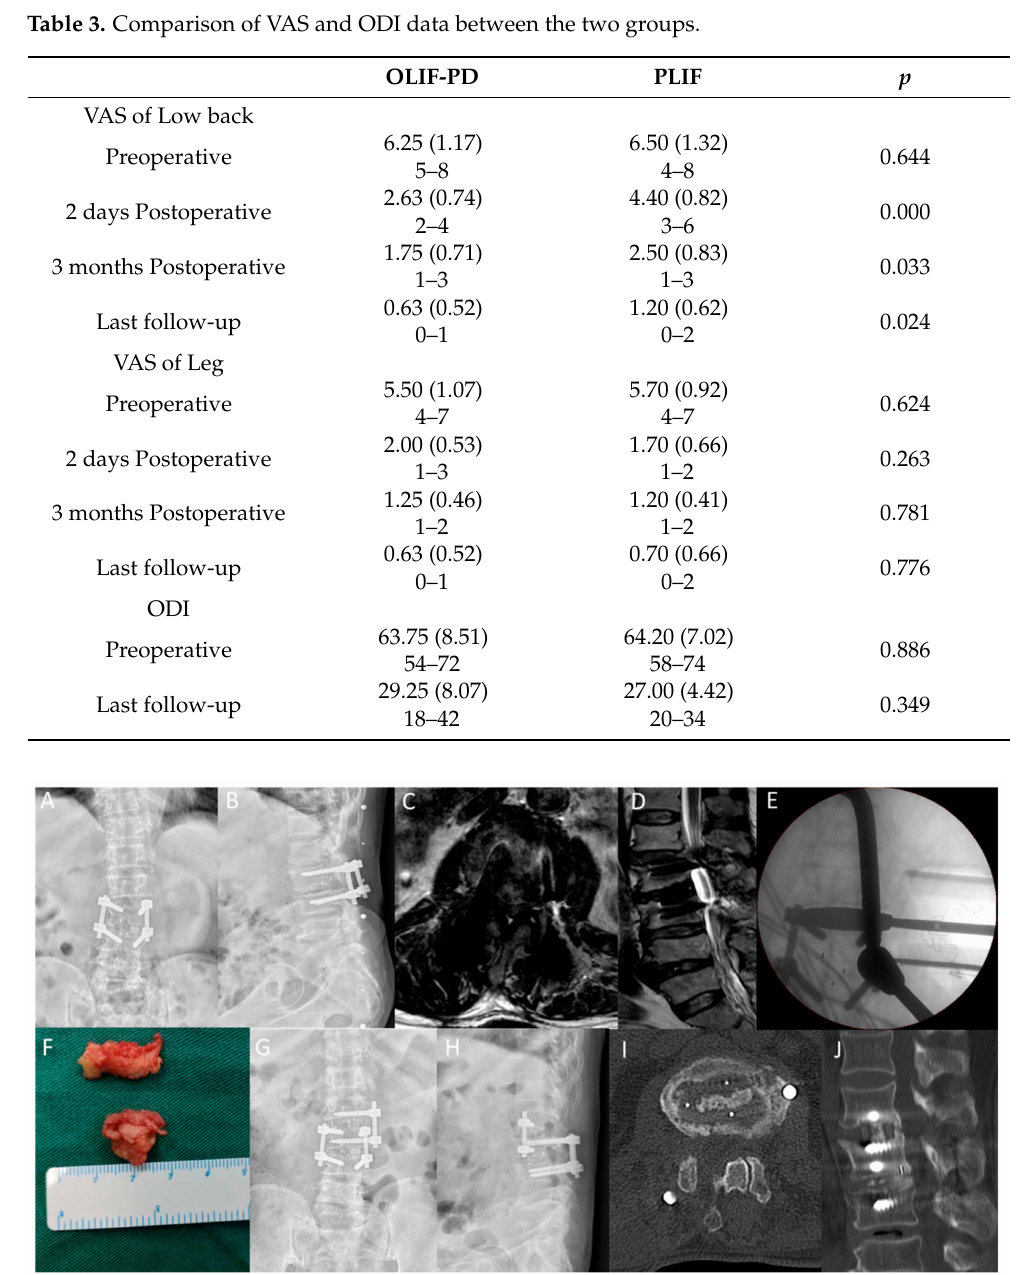
Figure 2. The patient, Male, 70 years old, was diagnosed L1/2 adjacent segment disease. ( A , B ): Ante- roposterior and lateral lumbar X-rays suggest lumbar 2/3 internal fixation. ( C , D ): lumbar